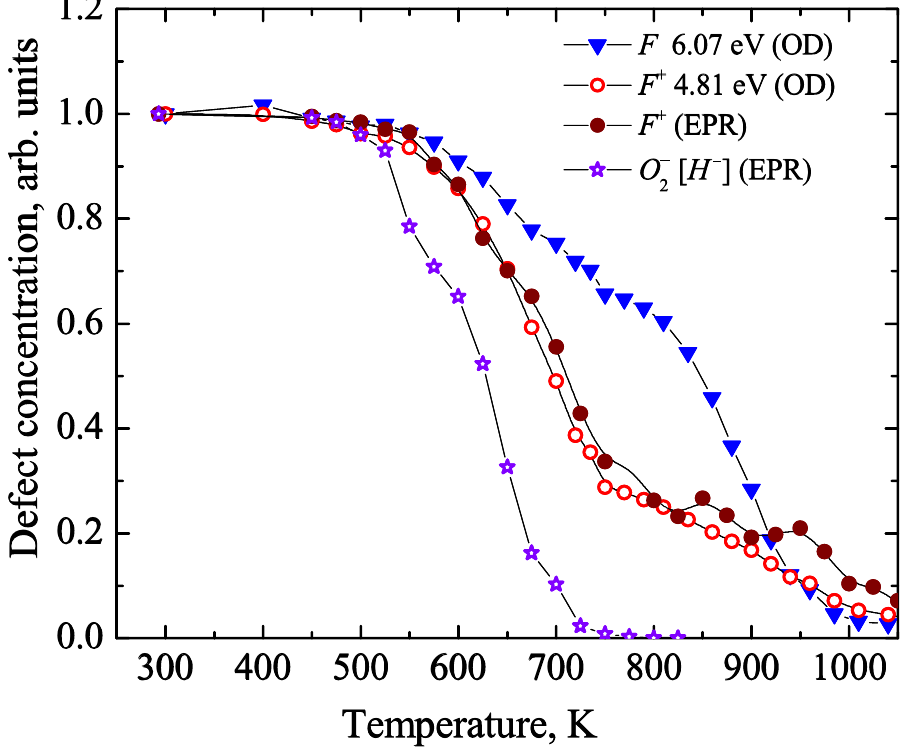
Figure 1. Thermal annealing kinetics of the electron-type F and F + centers as well as O 2 − dumbbells (that include H − interstitials, see for details Sect. 3, text related to Fig. 5). The decay of normalized defect concentrations which were estimated via the absorption band (OD) or EPR signal related to a certain radiation defect (see next Section for